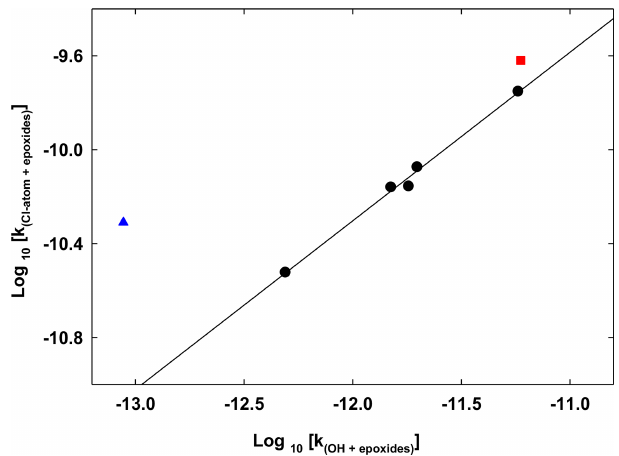
Figure 3. Double logarithmic plot (log 10 ) of the rate coefficients for the reaction of Cl-atoms versus the reaction of OH radicals with the epoxides (propylene oxide, 1,2-epoxybutane, trans -2,3- epoxybutane, cis -2,3-epoxybutane and 1,2-epoxyhexane). The solid line represents the unweighted least-squares fit to the data. Cyclo- hexene oxide is represented by the red square, while ethylene ox- ide is represented by a blue triangle. Both were not included in the least-squares